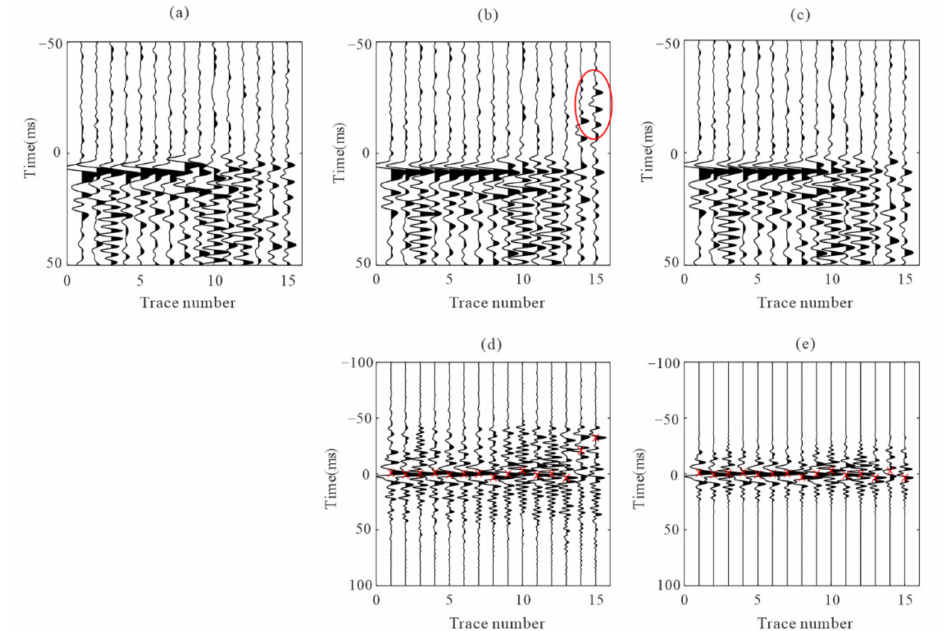
Figure 3. Waveforms after moveout correction based on adjusted picks from the time delay estimation. ( a ) the recording flattened using P pick times of one microseismic event example; ( b , c ) represent the recordings after adjusted picks correction using the normalized cross-correlation function and the proposed cross-correlation function, respectively; ( d , e ) are the normalized cross-correlation function and the proposed cross-correlation function, respectively. The red ‘x’ indicates the position of the maximum value. The red circle shows the wrong residual time